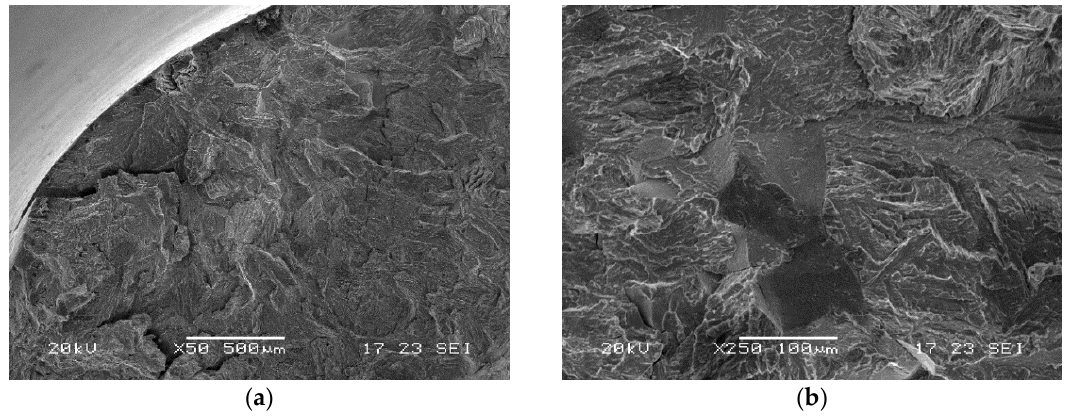
Figure 10. SEM images of fracture surfaces of a group O sample after SSRT test of immersion in NACE A solution ( a ) edge, ( b ) core.